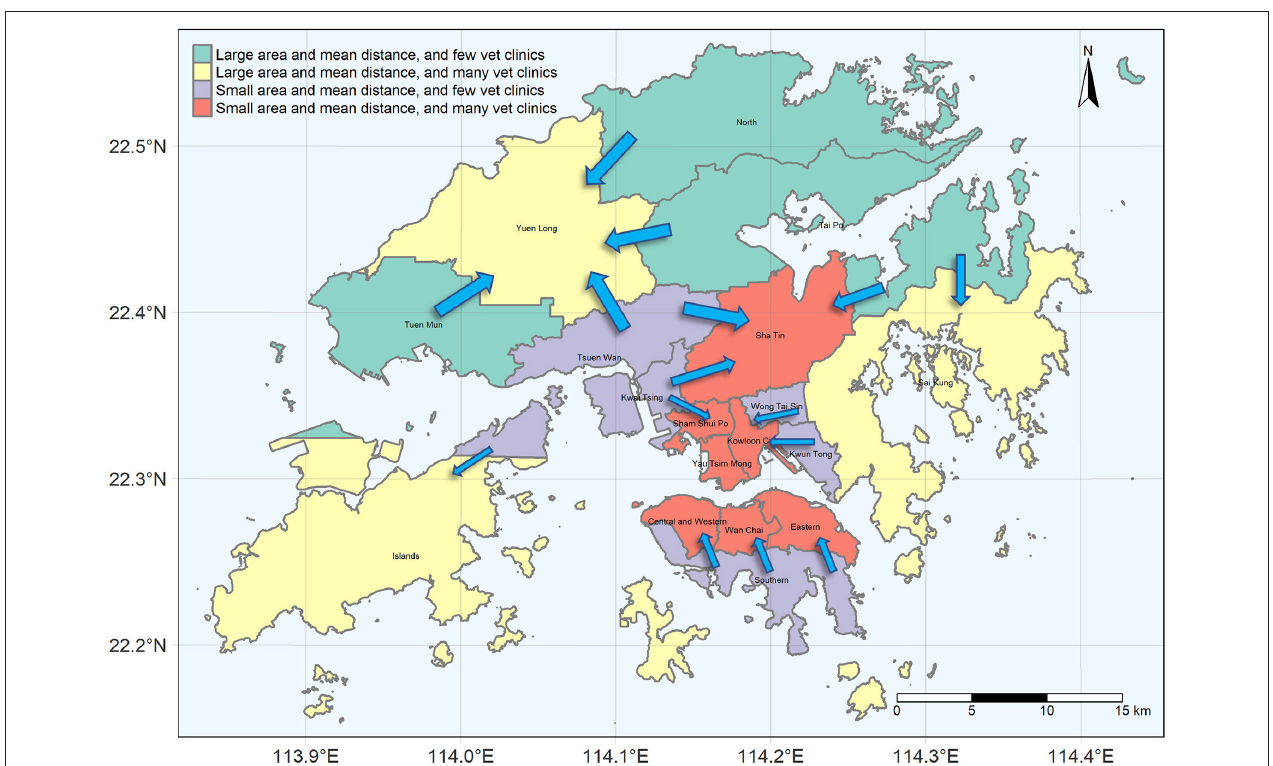
FIGURE 5 | Classification map derived from the PCA in Figure 4 . Arrows indicate the movement of